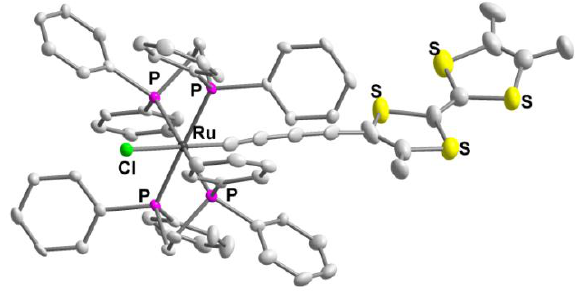
Figure 2. Molecular structure of trans -[RuCl(–C ≡ C) 2 –Me 3 TTF (dppe) 2 ] complex 9 (H atoms are omitted for clarity). Ellipsoids are drawn at the 50% probability level.